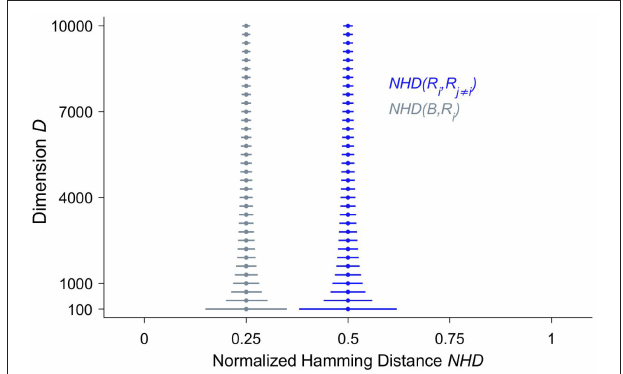
FIGURE 1 | The distributions of normalized Hamming distances ( NHD ) illustrate both the non-intuitive structure of hyperdimensional space and the similarity between a bundled hyperdimensional (HD) vector and its inputs. We have selected three random dense binary HD vectors R 1 , R 2 and R 3 and bundled them together to yield the HD vector B , i.e., B = [ R 1 + R 2 + R 3 ]. Bundling here denotes the componentwise application of addition followed by the majority rule. Then the pairwise NHD—the number of components where two vectors are different, divided by the dimension D —is computed among the input vectors NHD ( R i , R j 6= i ) shown in blue, and between B and each of its input vectors NHD ( B , R i ), displayed in gray. This procedure is repeated 50,000 times, yielding 150,000 distances for each distribution and for each dimension D , which increases from D = 100 to D = 10,000 in steps of 300. The dots represent the medians, and the whiskers indicate the 1–99 percentile ranges. One can clearly observe that, with increasing dimension D , the normalized Hamming distances between the random vectors concentrate around 0.5. In other words, the random vectors are almost orthogonal to each other. The distances between the bundled HD vector B and its input vectors is much smaller and concentrates around 0.25. Both of these characteristics become progressively and smoothly—i.e., there is no sensitive dependency—more pronounced with an increasing dimension D .